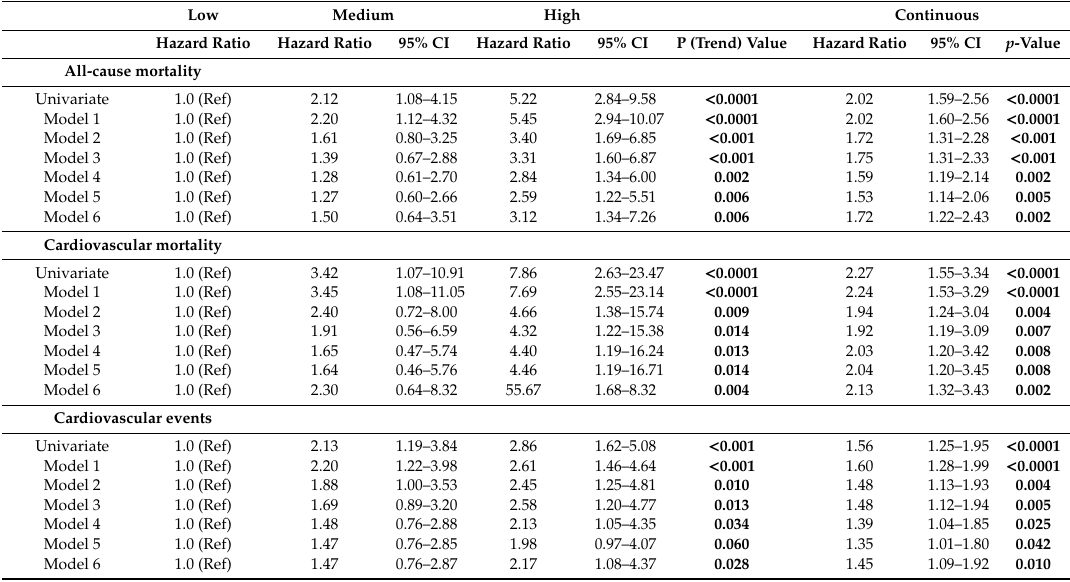
Table 4. Multivariable adjusted associations of CaScore with all-cause mortality, cardiovascular events, and cardiovascular mortality.